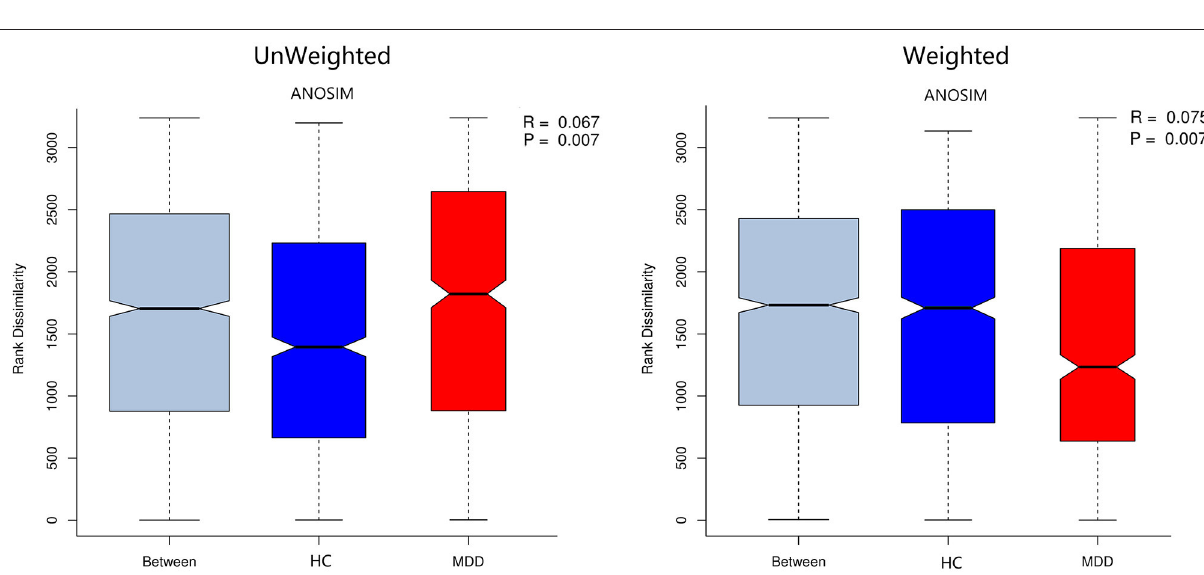
the two groups; the top four were uncultured_bacterium , uncultured_organism , Bacteroides_thetaiotaomicron , and Bacteroides_uniformis . After the strict FDR correction, at the